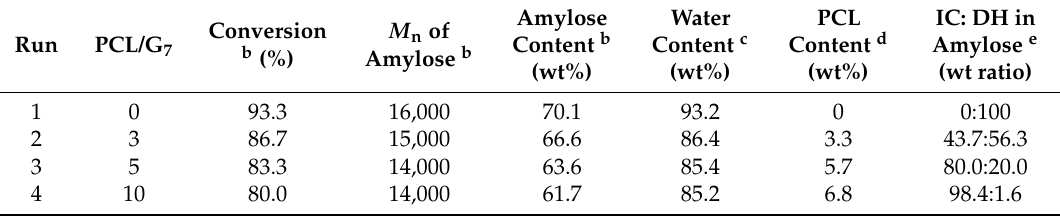
Table 1. Preparation of supramolecular network materials by phosphorylase-catalyzed enzymatic polymerization a